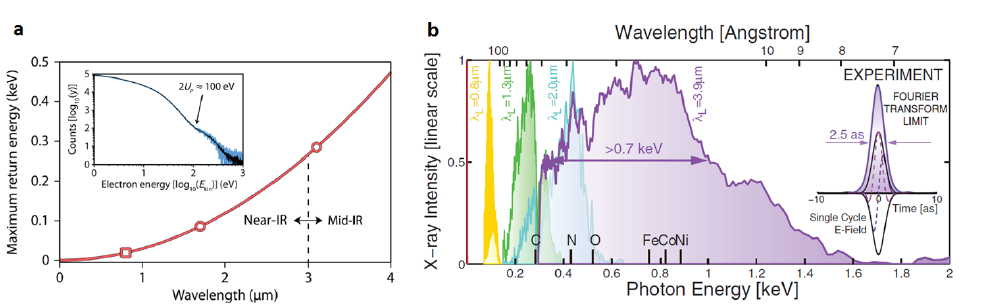
Figure 10. ( a ) Maximum electron return energy as a function of the wavelength for an intensity of 1.0 × 10 14 W/cm 2 . In the inset, an electron energy distribution is shown, as measured after ionization of the C 2 H 2 molecule using the 3.1 µ m radiation. Adapted with permission from [54], Copyright APS, 2015; ( b ) High-order harmonics spectral yield in xenon at different driving laser wavelengths (0.8 µ m, 1.3 µ m, 2 µ m and 3.9 µ m). In the inset, the Fourier transform–limited pulse duration for the High-order Harmonic Generation (HHG) radiation driven by the 3.9- µ m pulses is shown, corresponding to 2.5 attoseconds. Adapted with permission from [63], Copyright AAAS,